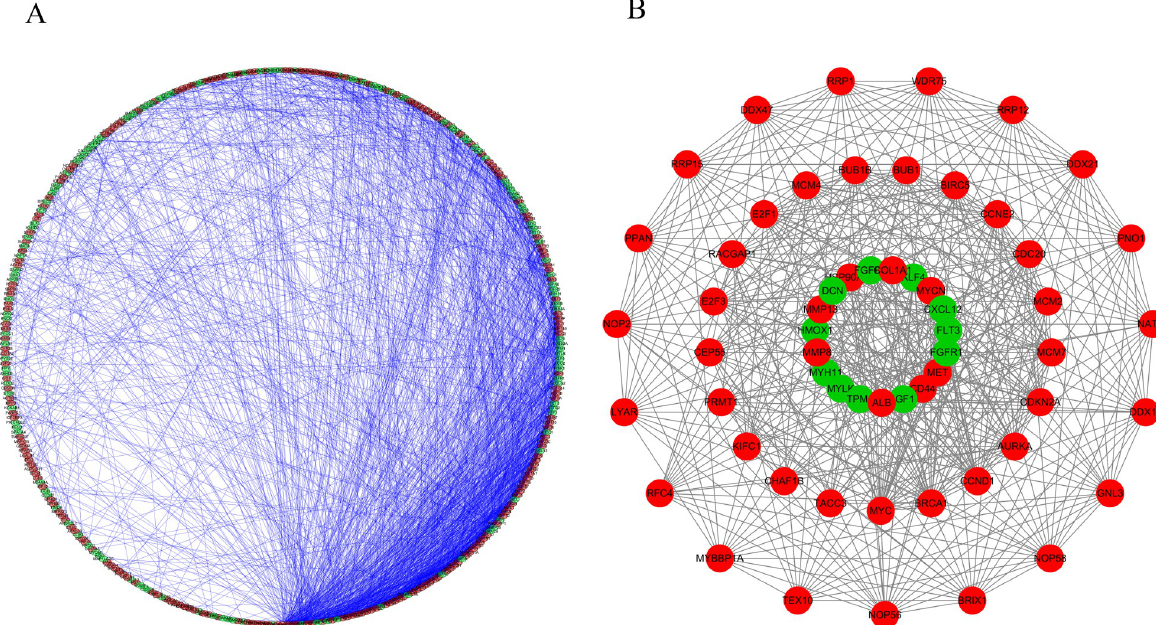
Fig 3. Protein-protein interaction (PPI) network and module analysis. (A) PPI network of DEMRGs. (B) Genes in the first three key modules are shown as rings from outermost (module 1) to innermost (module 3). Green and red represent down-regulated and up-regulated MRGs,